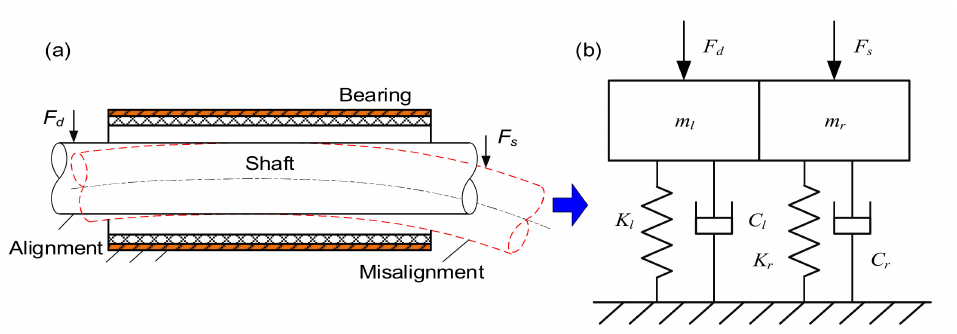
Figure 6. Dynamic model of the test bearing system: ( a ) structure of large aspect ratio bearing; ( b ) dynamic model of two-fulcrum